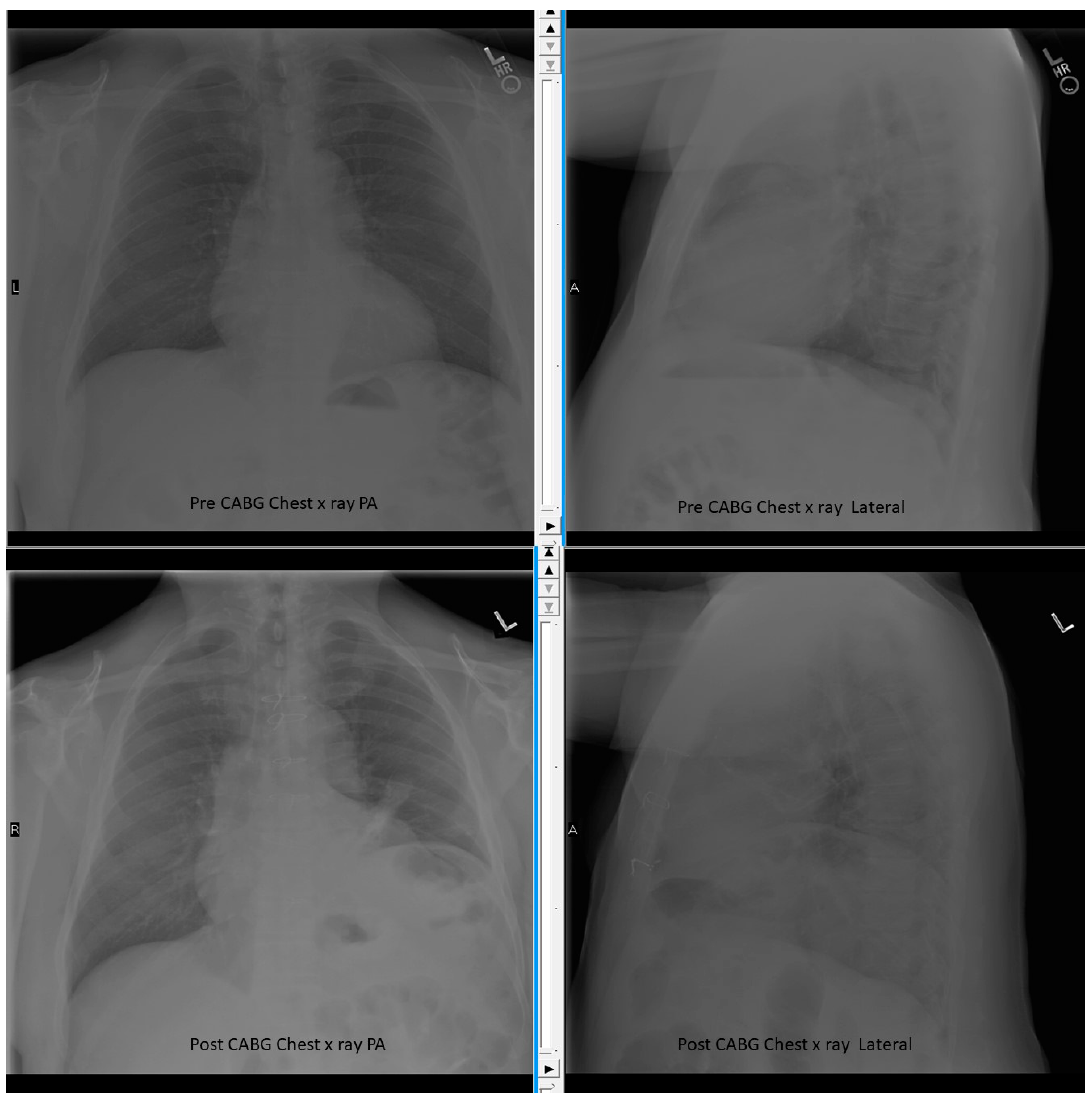
Figure 1. Chest X-ray Pre and Post Cardiac Bypass Surgery (CABG) showing elevated left diaphragm after surgery. The sternal metal suture wires also seen.